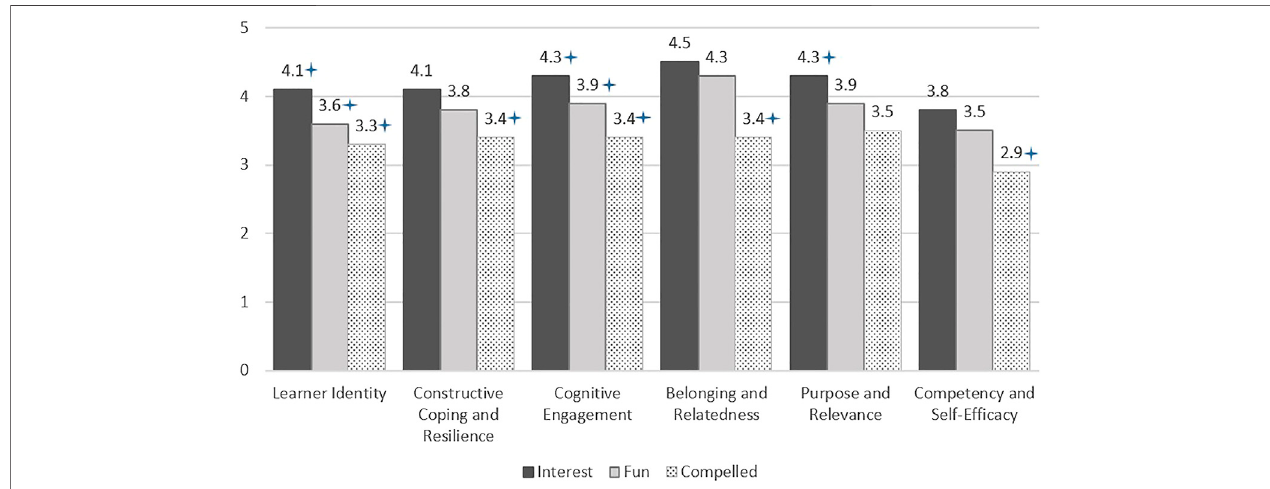
FIGURE2| Meanscoresforallyouthwhoparticipatedinthepre-surveybymotivationclass;meanswithanasteriskaredifferentatthe p < 0.05level.Allconstructs were measured on a scale of 1 (Strongly disagree) to 5 (Strongly agree). Note: n (cid:1) 202 for Interest; n (cid:1) 89 for Fun; n (cid:1) 70 for Compelled.